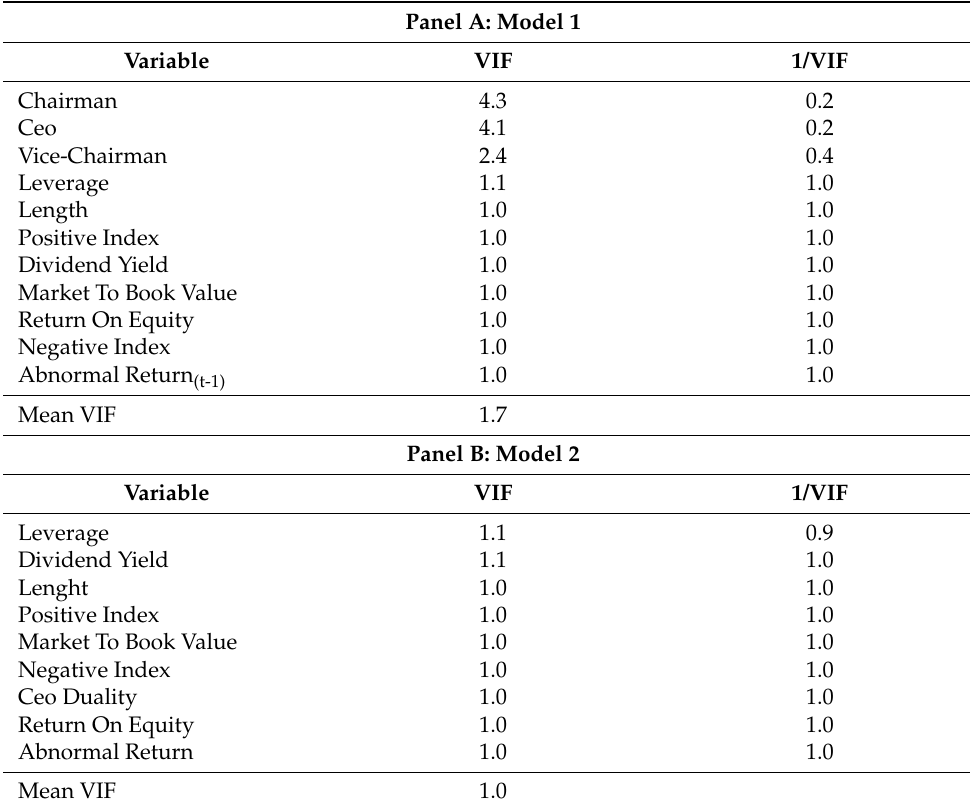
Table 6. Mean variance inflation factors (VIFs) for dependent variables of Model 1 (Panel A) and Model 2 (Panel